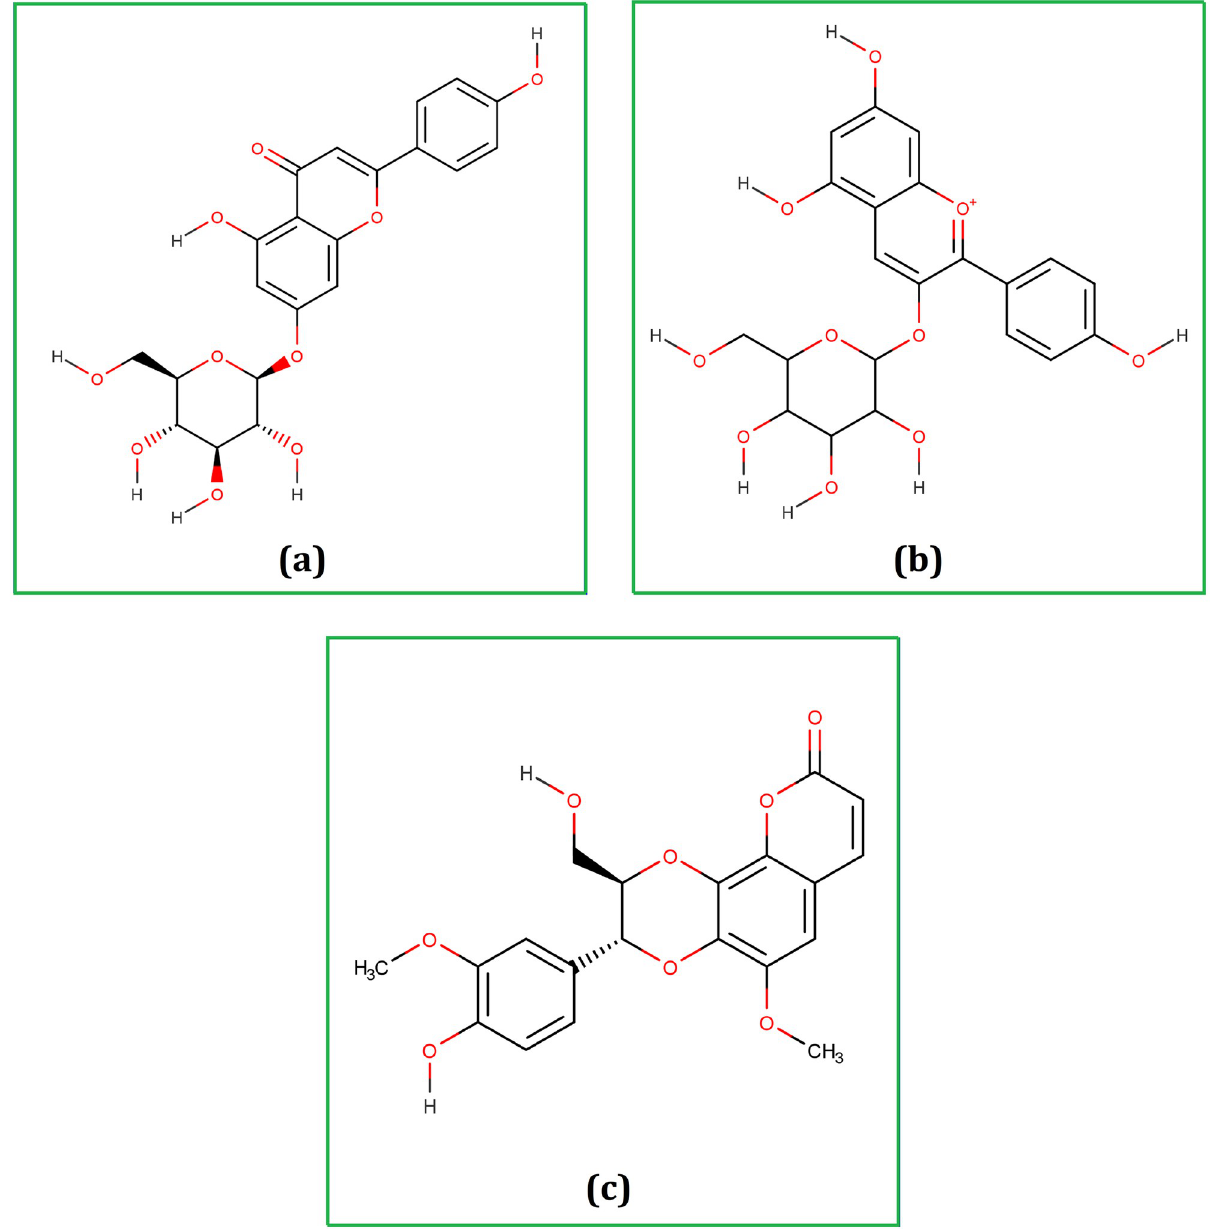
Fig 1. Chemical structure (2D) of Cosmosiine (a), Pelargonidin-3-O-glucoside (b), and Cleomiscosin A (c). The structures were drawn using the Marvin Sketch software.